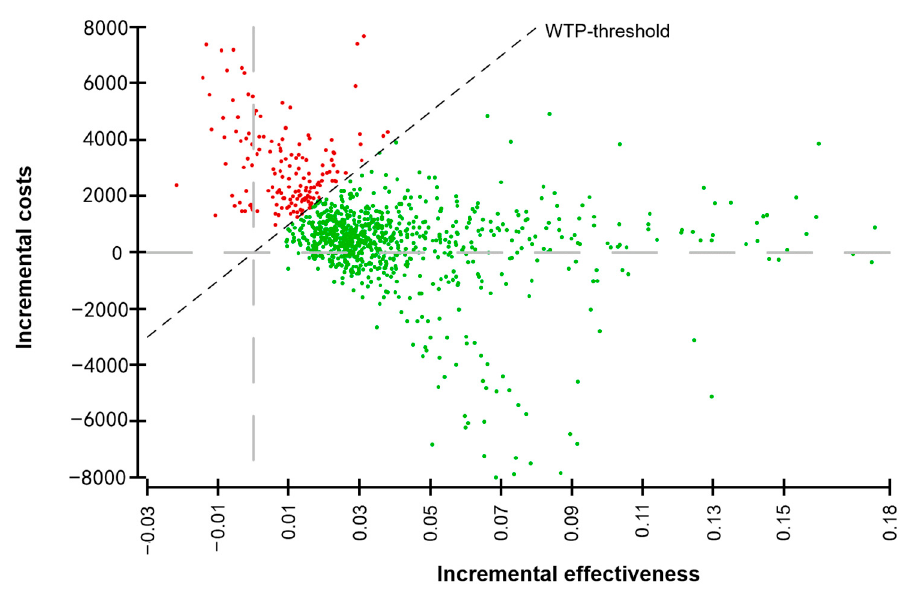
Figure 3. Cost ‐ effectiveness scatter plot. Incremental costs (US ‐ $) and effectiveness (quality ‐ ad ‐ Figure 3. Cost-effectiveness scatter plot. Incremental costs (US-$) and effectiveness (quality-adjusted life-years, QALYs) when comparing AB-MRI to DBT as determined in a Monte Carlo simulation. The majority of the iterations fall below the willingness to pay (WTP)-threshold of $100,000 per